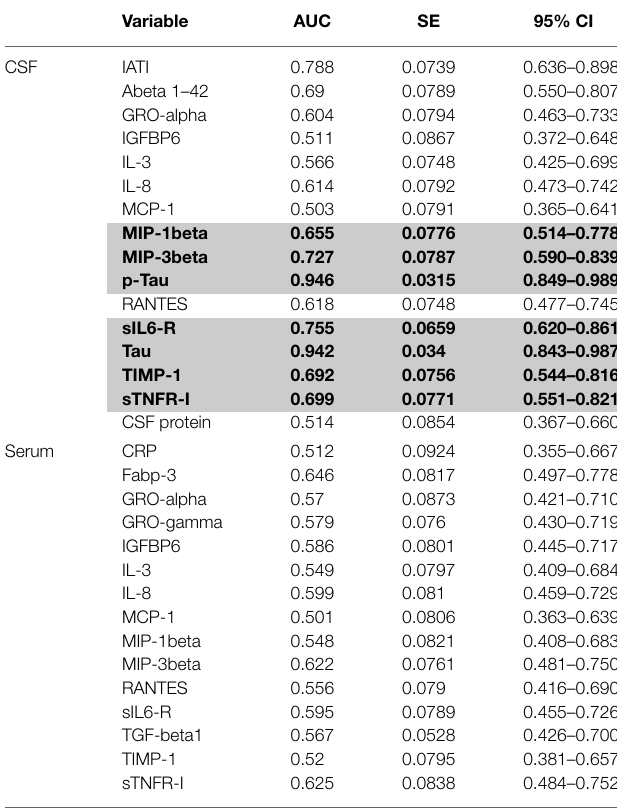
TABLE 3 | Values of area under the ROC curves .